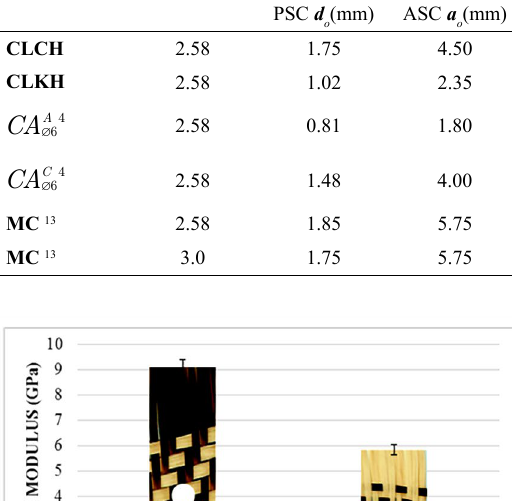
Table 6. Characteristic distances d and